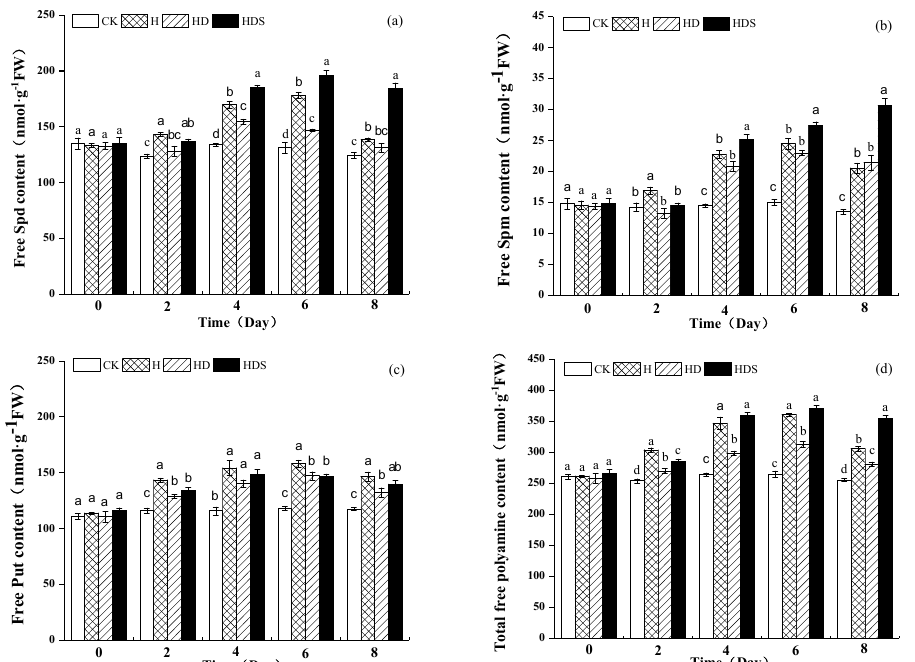
Figure 3. Effects of exogenous spermidine and D-arg on the free Spd ( a ), Spm ( b ), Put ( c ) and Total free polyamines ( d ) contents of lettuce under high-temperature stress. Vertical bars represent standard deviations of the mean ( n = 3). Values above each vertical bar followed by different letters show significant differences ( p < 0.05). CK, 22 ◦ C/17 ◦ C, deionized water; H, 35 ◦ C/30 ◦ C, deionized water; HD, 35 ◦ C/30 ◦ C, 1 mM D-arg; HDS, 1 mM D-arg+ 1 mM Spd.